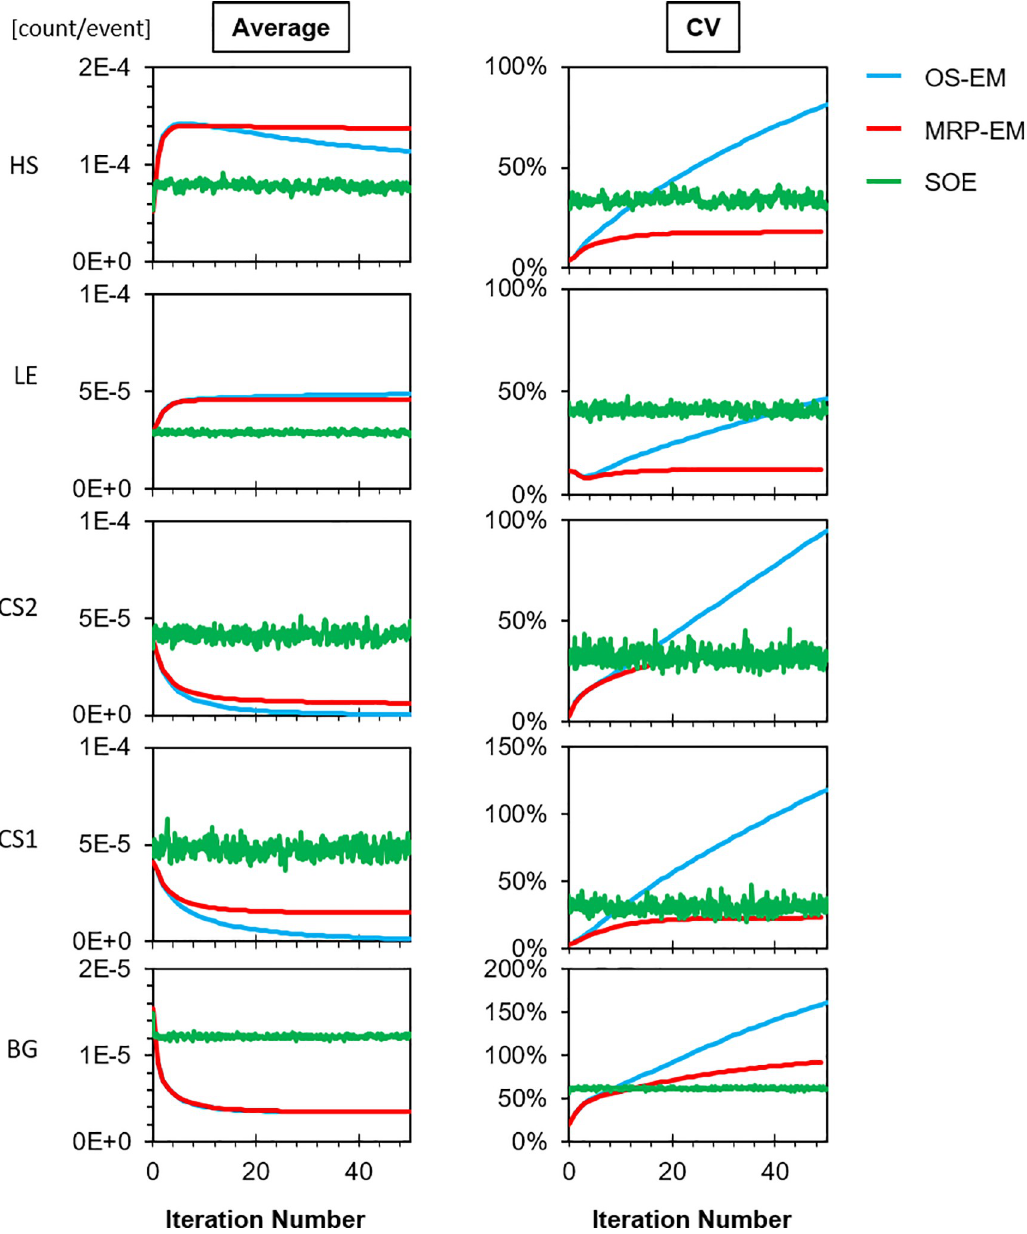
Fig 6. Changes in average and CV of HS, LE, CS1, CS2, and BG of the reconstructed images for each iterative algorithm (OS-EM: blue, MRP-EM: red and SOE: green). The x-axis value (iteration number) of SOE is 10 times greater than that of OS-EM and MRP-EM. The average values (CV) of HS, LE, CS1, CS2, and BG for the analytical method were 1.0 × 10 − 4 (6.8%), 4.1 × 10 − 5 (10%), 1.6 × 10 − 5 (36%), 1.0 × 10 − 5 (73%), and 9.3 × 10 − 6 (65%), and those for BP were 6.8 × 10 − 5 (3.6%), 3.0 × 10 − 5 (12%), 4.1 × 10 − 5 (3.0%), 3.7 × 10 − 5 (4.8%), and 1.3 × 10 − 5